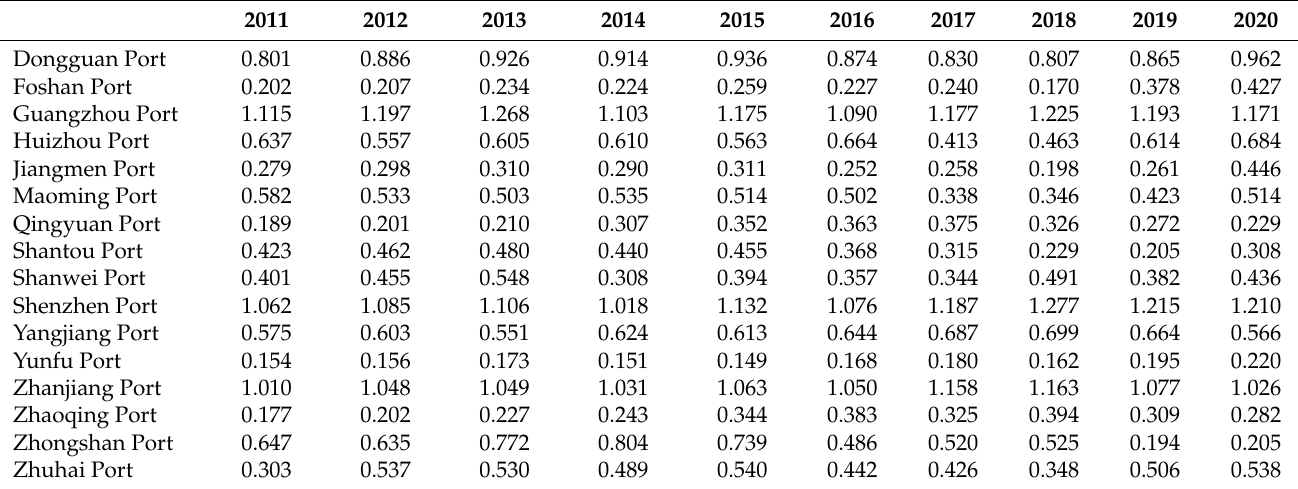
Table 3. Port efficiency by port from 2011 to